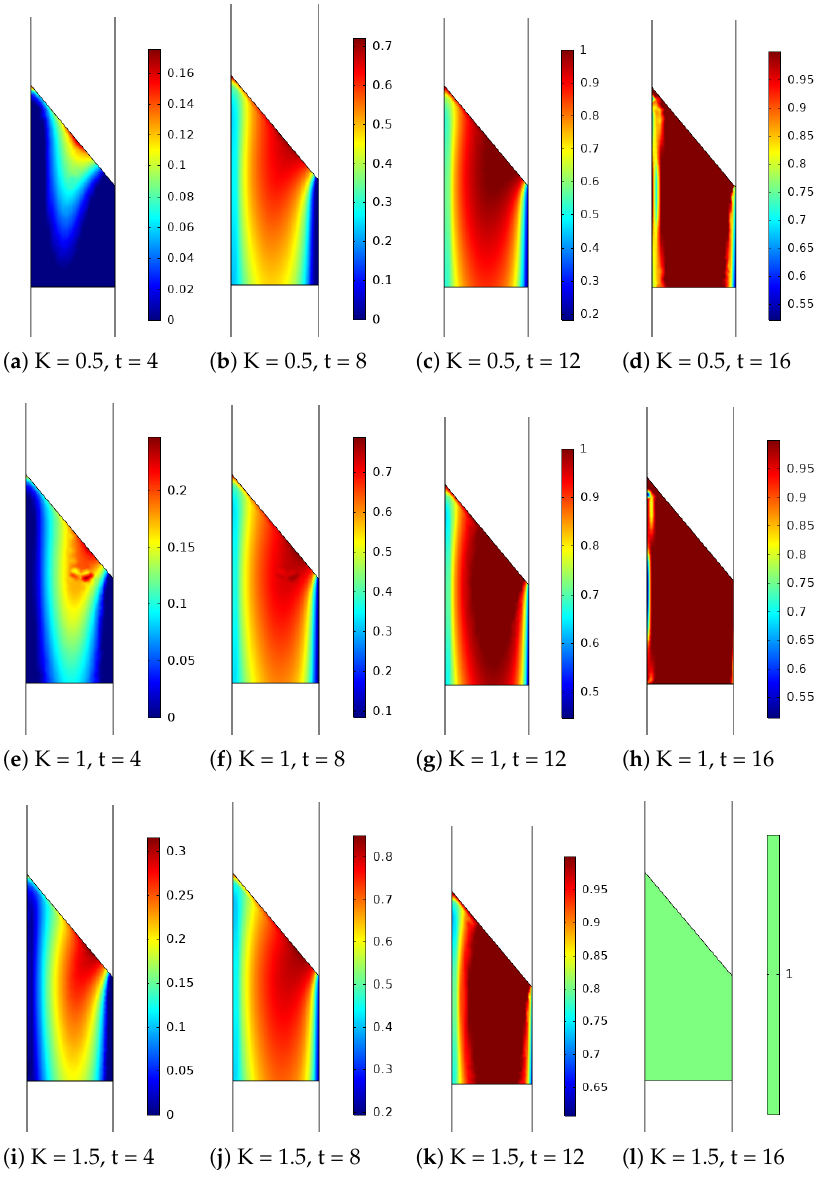
Figure 6. Effects of the sequential velocity parameter (K) on the distribution of liquid fraction (LFR) at various time instances (t in minutes) ( a – l ) (constant MF, Ha = 15, M = 0.5, φ =